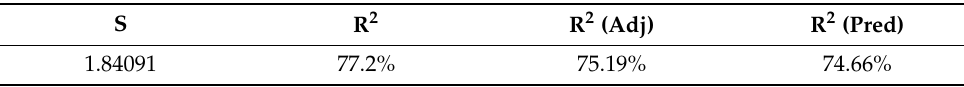
Table 6. Summary of the model’s adequacy check.